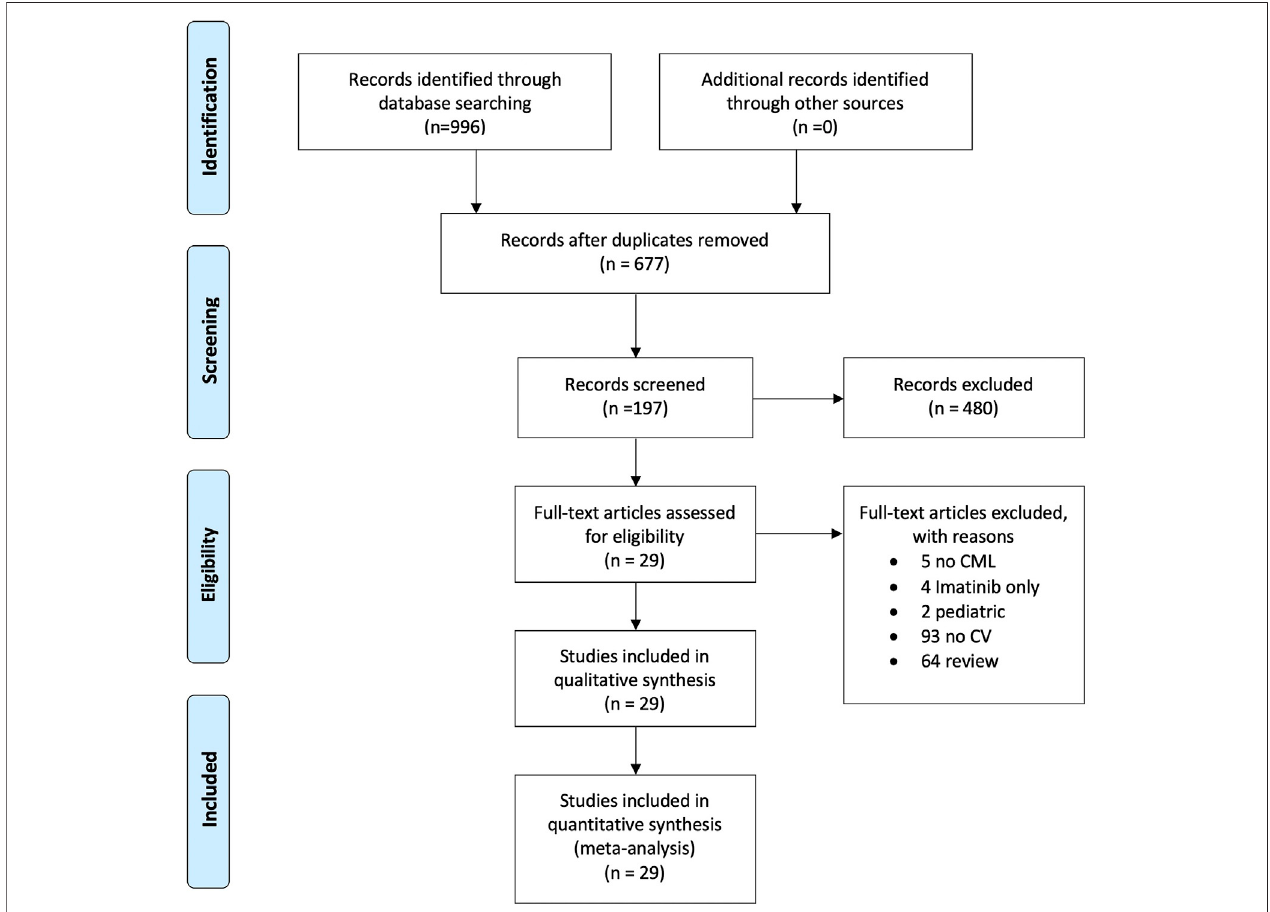
FIGURE 1 | Study fl ow